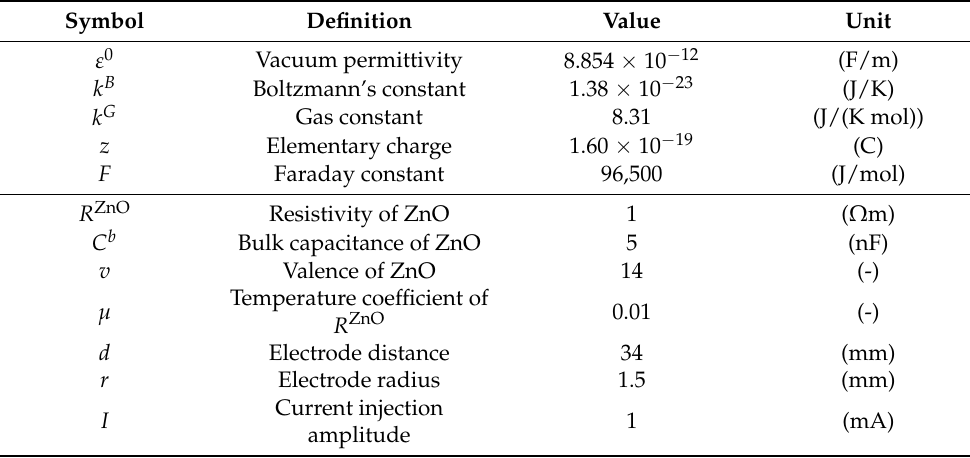
Table 1. Assumption values for each variable to estimate R and thermal noise to R ratio, η , in the case of molten ZnO material at T = 1000~1200 ◦